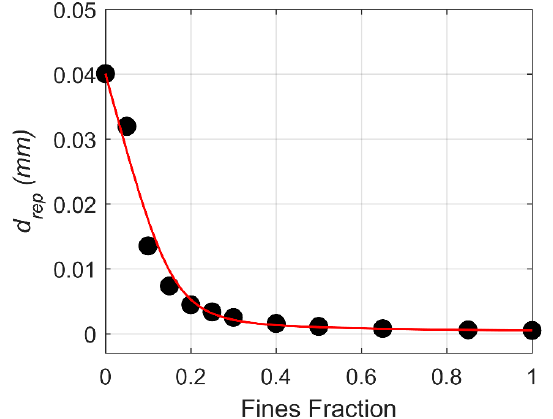
Figure 8. Representative particle size ( d rep ) as function of fines fraction. Black circles refer to the calculated values of d rep based on porosity and permeability measurement for sand-clay mixtures from Reference [77] which is the same data set used for mixture M1 (Marion et al. [20]. The red curve is calculated using Equations (8) and (9) for a = 10, while f ∗ value is obtained from the current packing model.